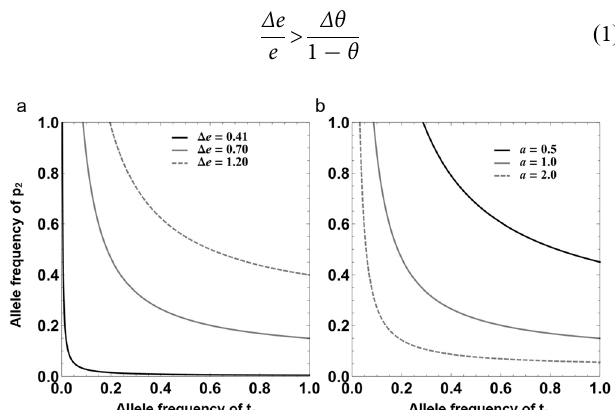
Fig. 1 The stable internal equilibria of the two-locus models for the male preference P 2 and female trait T 2 , allele frequencies when choosy males have a trade-off between mate guarding and seeking additional mating. a Effect of the relative increase in fi tness gained from additional mating by P 2 males ( Δ e e ). The three lines in this graph represent different values of Δ e . b Effect of different strengths of male preference ( a ). The parameters behind those lines satisfy Δ e e > Δθ , where Δ e e represents the relative increase in 1 (cid:1) θ fi tness gained from additional mating by P 2 males when they mate with unpreferred T 1 females, Δθ represents the relative loss of paternity. For 1 (cid:1) θ both panels, e = 0.8, Δθ ¼ 0 : 1, and θ = 0.8. We set a = 1 in ( a ) and Δ e ¼ 0 : 7 in ( b